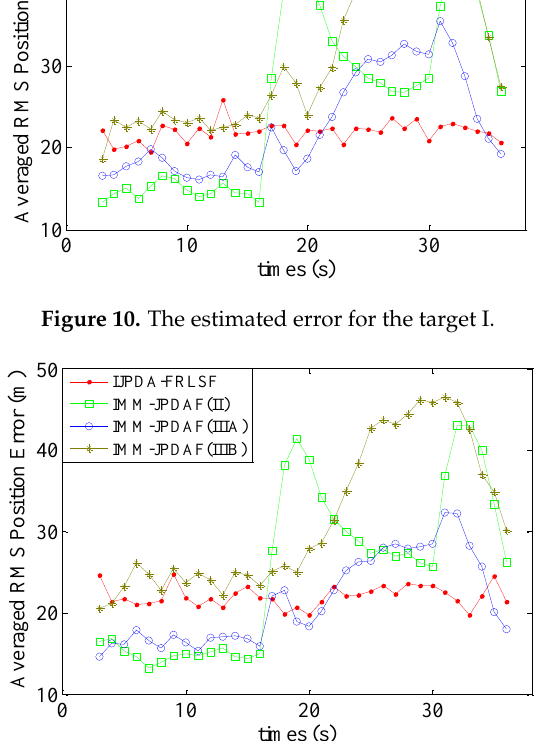
Figure 11. The estimated error for the target II.